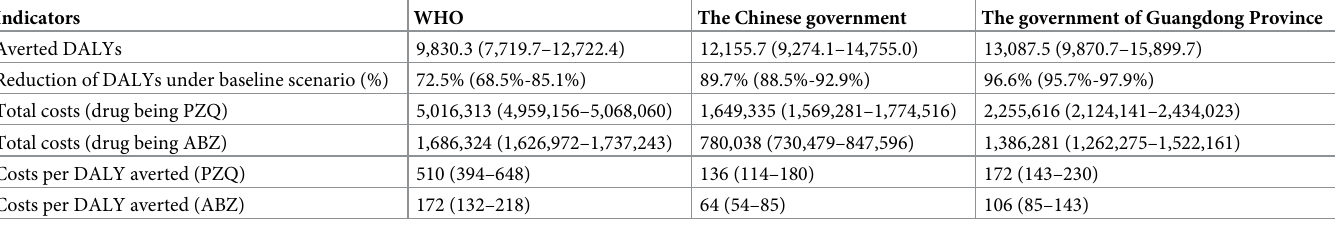
Table 1. The costs and averted DALYs of the three recommended strategies for C . sinensis infection � . Indicators